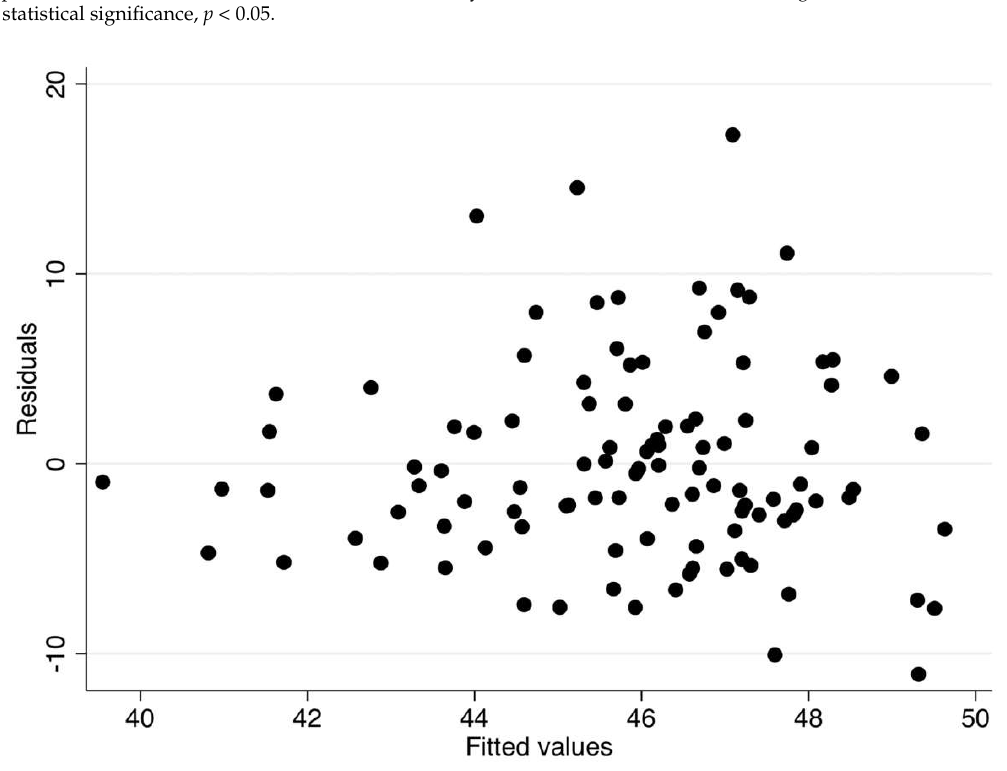
Figure 1. Residual vs. fitted plot showing a heteroscedastic pattern across the range of fitted VO 2 Peak scores.